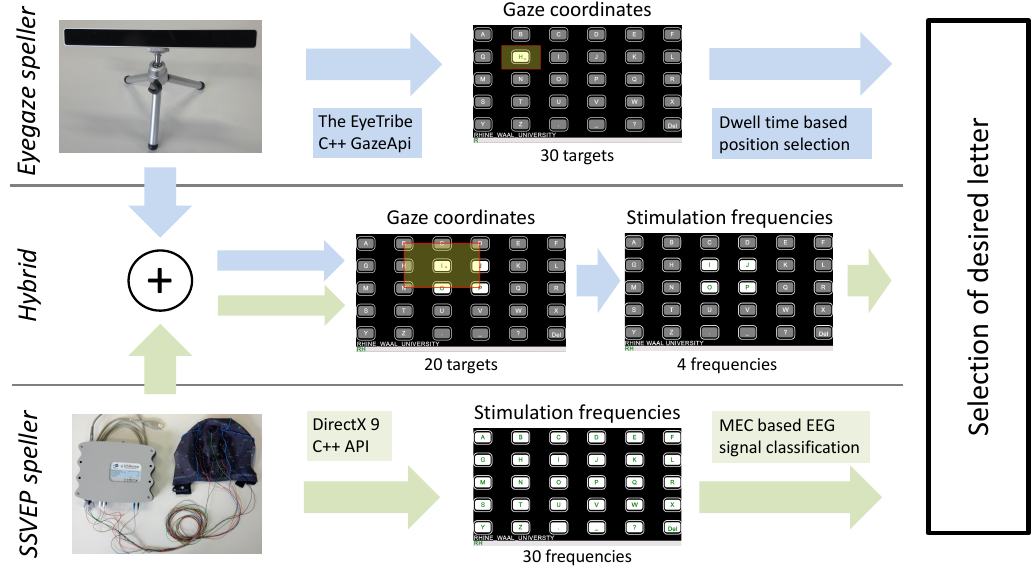
Figure 1. System overview of the three tested applications showing hardware, signal processing options, user interfaces and the system